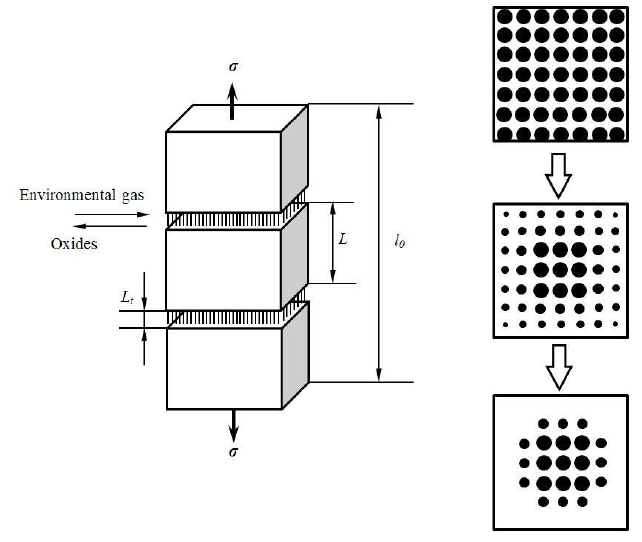
Figure 3. The schematic of fiber oxidation in multiple cracked C/SiC composite.